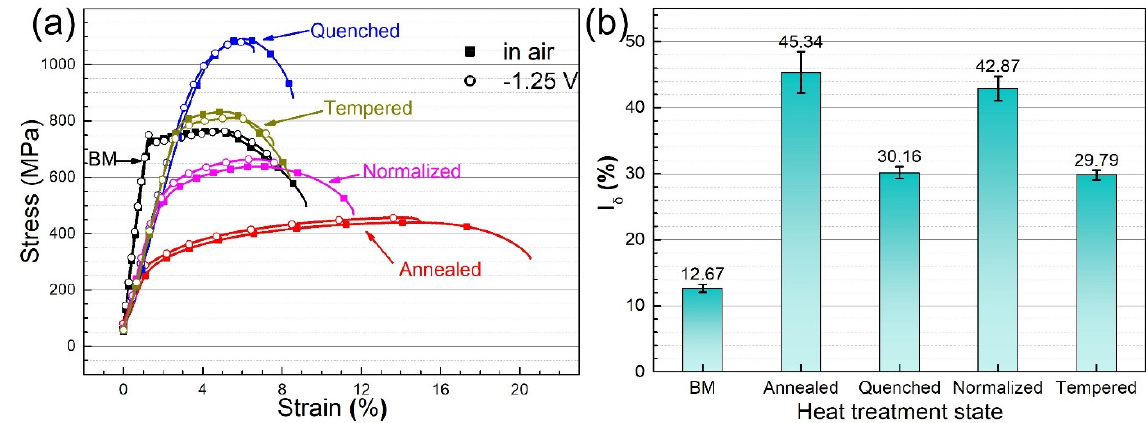
Figure 14. Stress–strain curves of the steel with different microstructures ( a ) and the corresponding hydrogen-induced cracking (HIC) susceptibility ( b ) in terms of the elongation loss rate in NaOH solution containing thiourea at − 1.25 V (vs. Ag/AgCl).